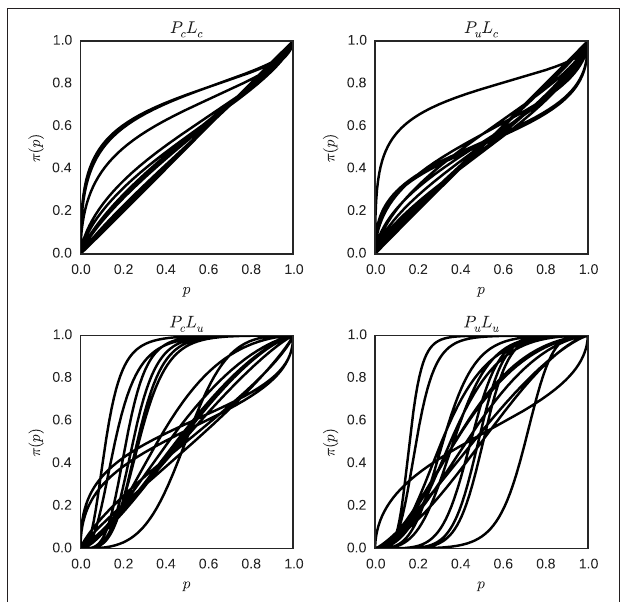
FIGURE 11 | Hierarchical distributions for parameter p 0 in different conditions ( P c L c , P u L c , P c L u and P u L u ). The hierarchical distributions p 0 ∼ beta ( ϕλ,( 1 − ϕ)λ ) use the posterior means of the hyper-parameters ϕ and λ for the different conditions. likelihood conditions ( β = − 0.15 , SE = 0.05 , z = − 3.00 , p =